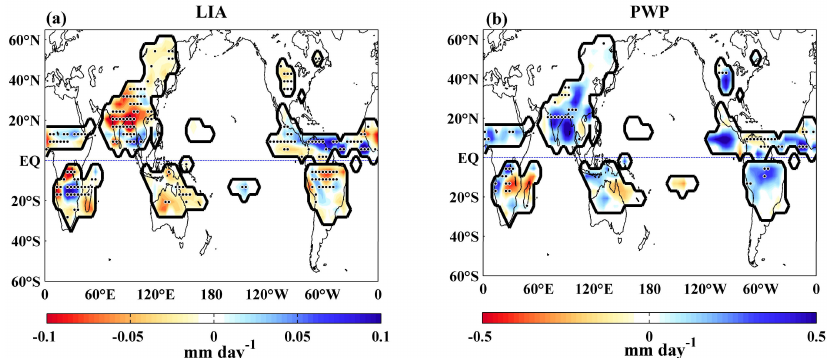
Figure 2. Global monsoon precipitation (GMP) domain and precipitation. Comparison of the GMP maps obtained by using ( a ) PWP (1900–2000) and ( b ) LIA (1250–1850) minus pre-industrial climatology (500–1850) in full forcing run. The monsoon domain is those regions where the annual range (local summer mean minus winter mean) of precipitation rate exceeds 2.0 mm/day and the local summer precipitation exceeds 55% of the annual total. Here, local summer is defined as May through September (MJJAS) for the NH and November through next March (NDJFM) for the SH. Stippling indicates statistical significance (10% significance level) based on t -test.